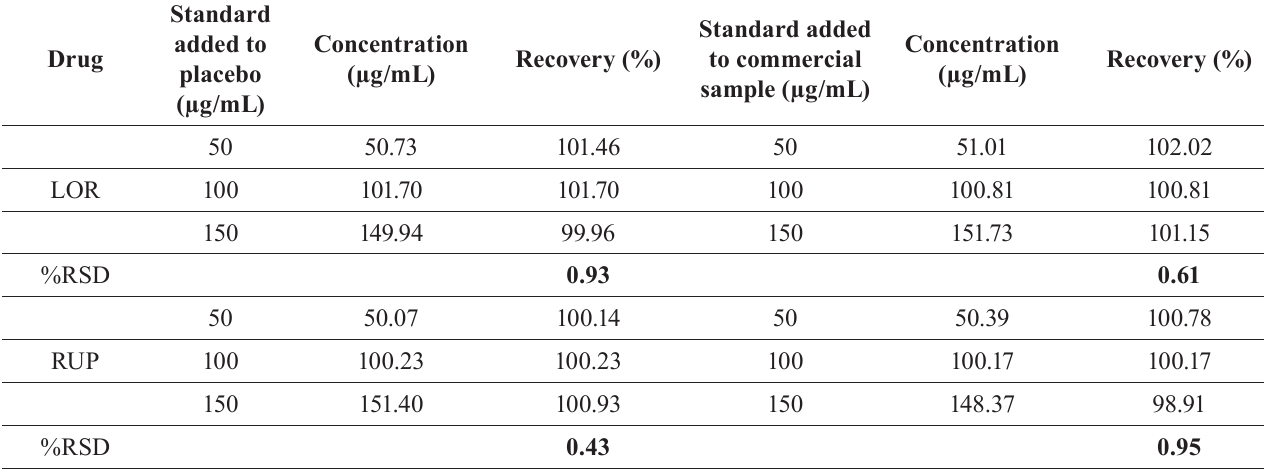
TABLE V - A ccuracy of the proposed methods